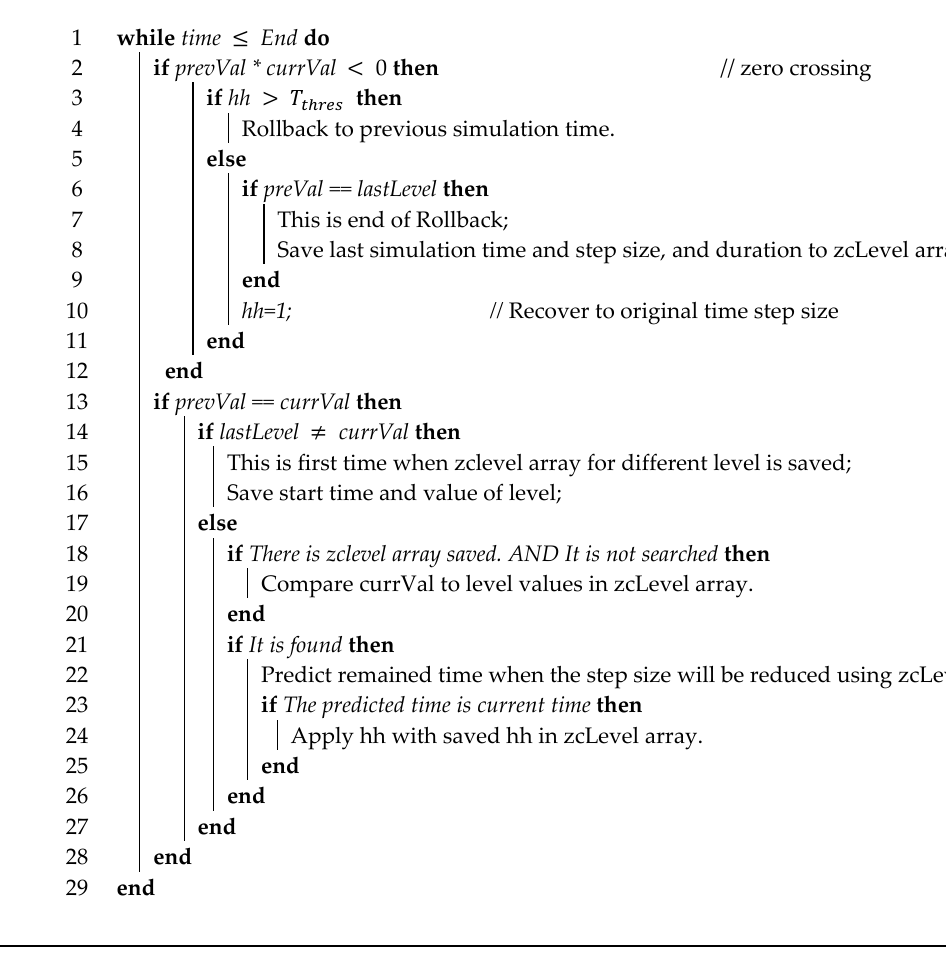
Sensors 2019 , 19 , x 13 of Algorithm 3: level zero crossing algorithm